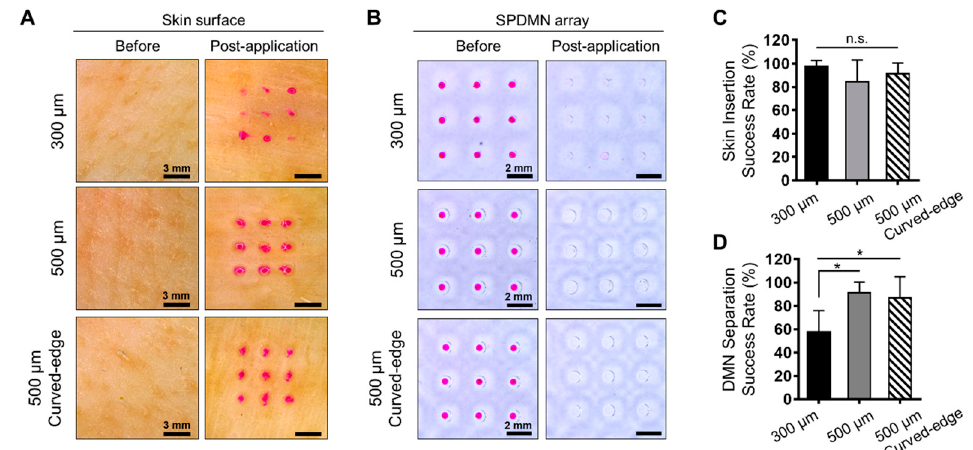
Figure 3. Application of SPDMNs into pig cadaver skin. ( A ) Application of DMNs fabricated over 300 µ m, 500 µ m, and curved-edge 500 µ m micropillars into the skin. Application spots over the skin surface indicate successful separation of DMNs from micropillars. ( B ) Top-view images of SPDMNs pre- and post-application. DMNs were completely separated from micropillars post-insertion. ( C ) Comparison of skin insertion success rates. There were no significant di ff erences between the insertion rates of SPDMNs. ( D ) The separation evaluation of SPDMNs confirmed significantly lower separation rates in 300 µ m micropillars than in 500 µ m and curved-edge 500 µ m micropillars. Scale bars in panels of ( A ) is 3 mm and ( B ) is 2 mm. Data in ( C , D ) are expressed as mean ± S.D. *: p < 0.05. n.s.: not